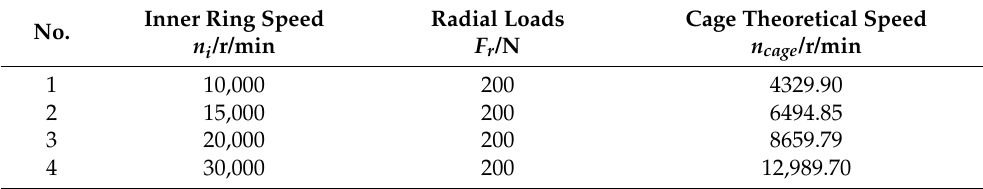
Table 2. Bearing operating